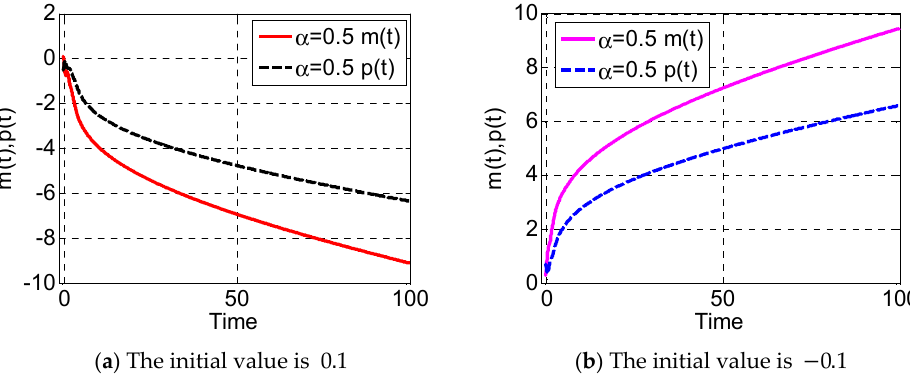
Figure 1. Time response sequence diagram of the two-dimension FOGRN when α = 0.5.